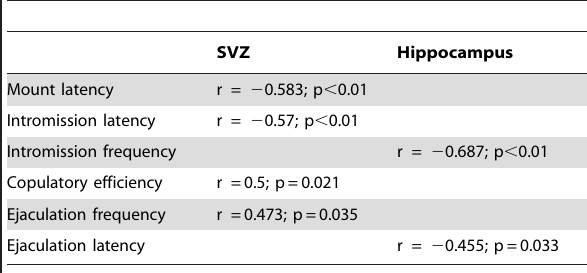
Table 1. Correlational analysis of BrdU + ve cells in SVZ and hippocampus and sexual behavior components.